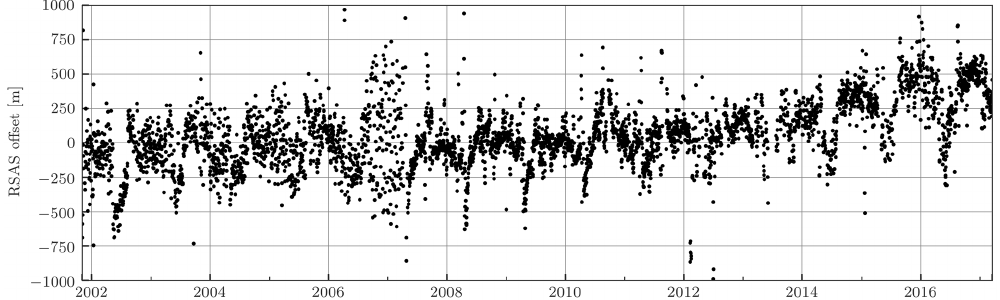
Figure 5. Daily average RSAS tangent height offset after subtracting the geographic average from Fig. 3. This is the final correction that is used in v5.10 data processing.